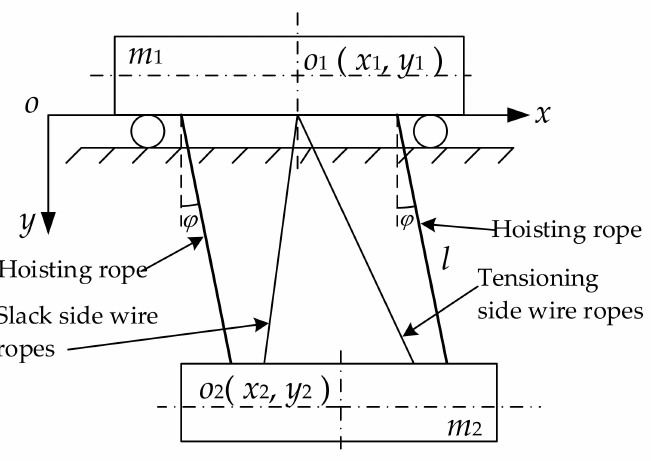
Figure 3. Schematic diagram of the simplified structure of the crane trolley–load system.